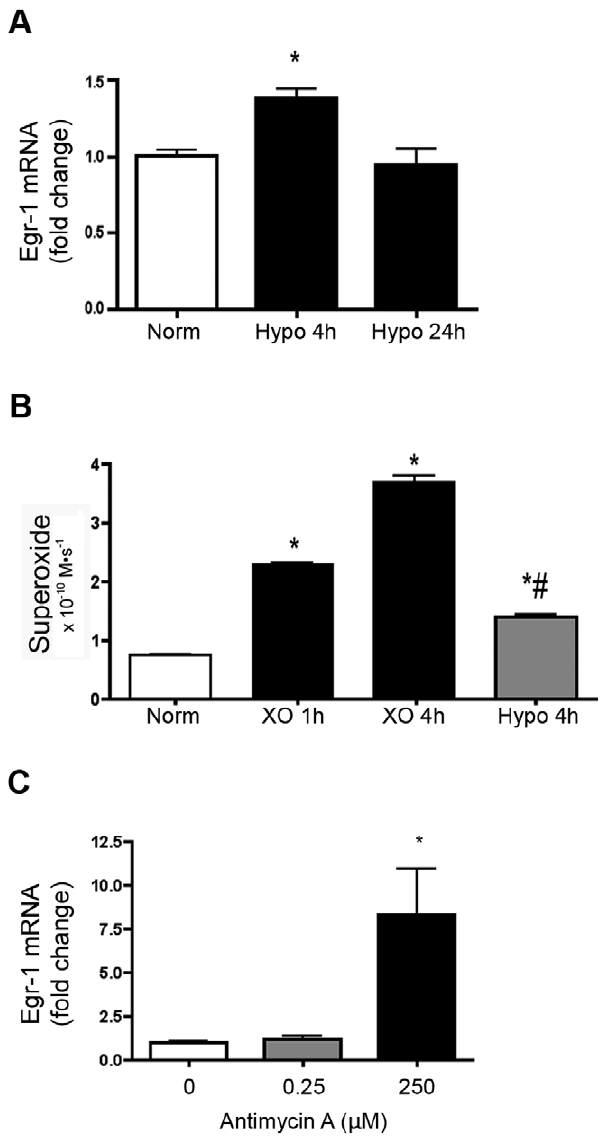
Figure 5. Exposure of calf PASMC to hypoxia resulted in less induction of Egr-1 and less extracellular superoxide generation than XO. A. Egr-1 mRNA expression in calf PASMC exposed in sealed humidified gas chambers with 21% or 1% O 2 plus 5% CO 2 and balanced N 2 at 37 u C for 4 and 24 hours and shown compared to XO/HX treatment for 1 hour (XO). B. Extracellular O 2. 2 production in PASMC exposed to XO/HX (XO) or hypoxia as described above. 20,000 cells treated in a final volume of 150 m L were exposed to XO/HX (XO) for 1 or 4 hours or hypoxia for 4 hours at 37 u C and pH 7.4 in the presence of XTT. An extinction coefficient of 21600 M 2 1 cm 2 1 was used to calculate O 2. 2 flux (M-s 2 1 ). C. Egr-1 mRNA expression in calf PASMC exposed to antimycin A to increase endogenous ROS generated in the mitochon- dria. 20,000 cells were exposed to 0.25 m M or 250 m M antimycin A for 2 hours at 37 u C. All data expressed as mean 6 SEM. *p , 0.05 vs. vehicle-treated cells, n=3. doi:10.1371/journal.pone.0027531.g005 Xanthine oxidase-derived extracellular reactive oxygen species upregulated Egr-1 via the activation of ERK1/2 in pulmonary artery smooth muscle cells. MAPK/ERK signaling pathways have been shown to regulate Egr-1, and many MAPK enzymes are redox sensitive. To determine if